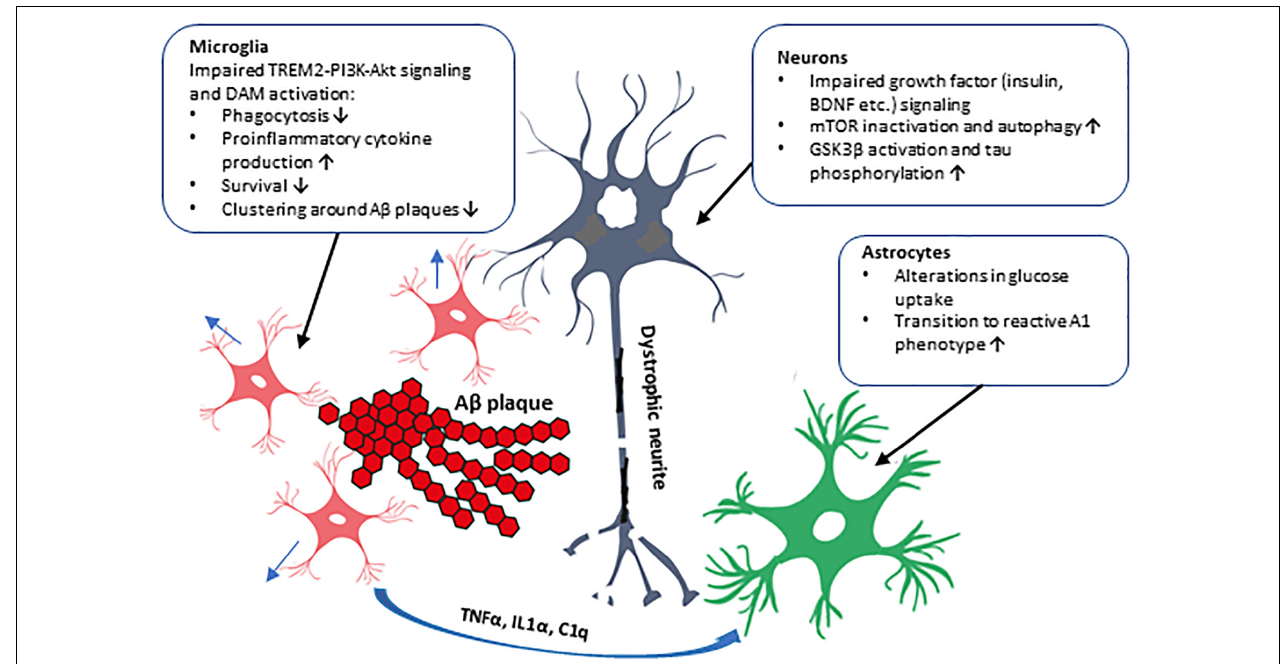
FIGURE 2 | Schematic illustration of the cell type-specific effects of impaired PI3K-Akt signaling in AD brain. The impaired PI3K-Akt signaling might be due to decreased PI3K subunit levels observed in the brain of AD patients or due to T2D, which alters insulin levels and affects PI3K-Akt pathway in the brain, augmenting AD pathogenesis. These alterations could have distinct effects in different cell types in the brain, as shown in the figure. Activation of PI3K-Akt signaling pathway by several extracellular stimuli, such as growth factors (insulin, BDNF, etc.), affects proliferation, metabolism, and survival in various cell types. In neurons, GSK3 β activity and tau phosphorylation and mTOR activity affecting autophagy are influenced. Microglial transit to DAM phenotype, phagocytosis, and cytokine production, and formation of microglia clusters around A β plaques are affected. Inflammatory cytokines secreted by microglia activate astrocytes, which transit to the reactive A1 phenotype unable to support neuronal outgrowth and synaptogenesis. Furthermore, genetic variation in AKT2 gene alters glucose uptake, probably in astrocytes, potentially affecting brain energy metabolism.